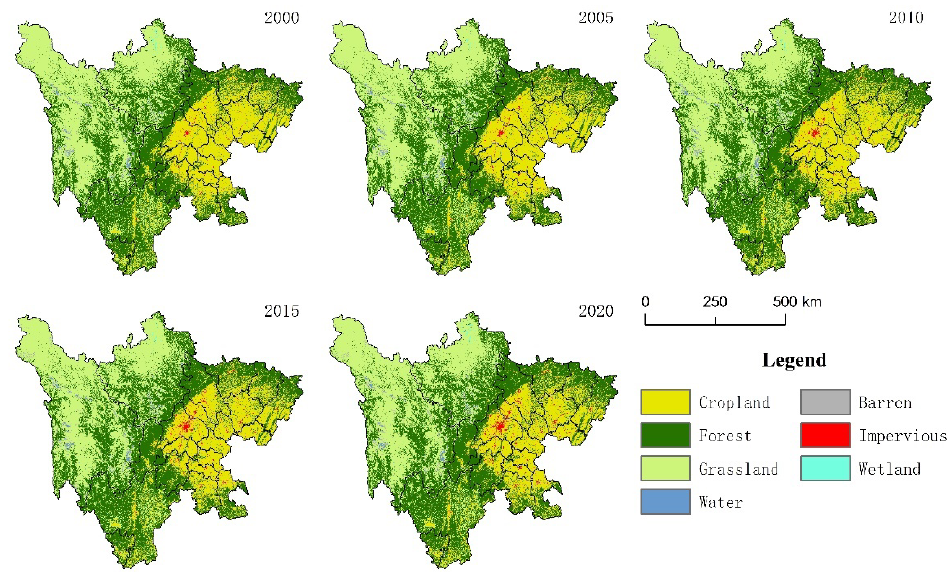
Figure 2. Spatial distribution of land use from 2000 to 2020. Table 2. Land use area in Sichuan Province from 2000 to 2020.